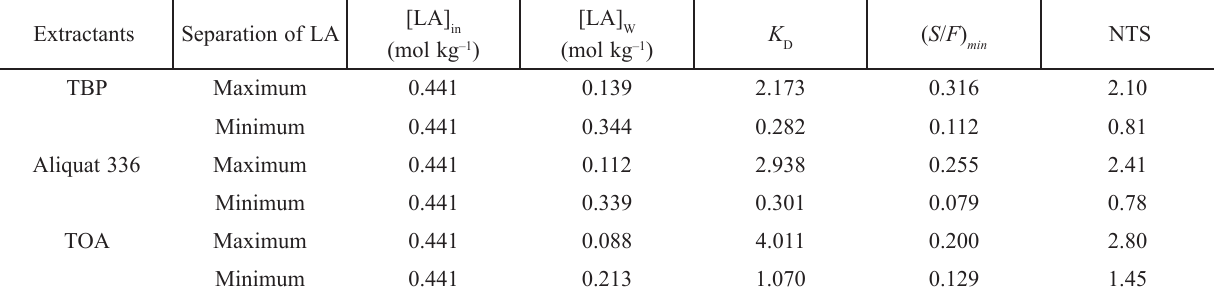
Table 4 – Calculation of minimum solvent-to-feed ratio (S/F) and number of theoretical stages (NTS) for the maximum and mini- mum separation of LA with initial concentration of 0.441 mol kg –1 Extractants Separation of LA